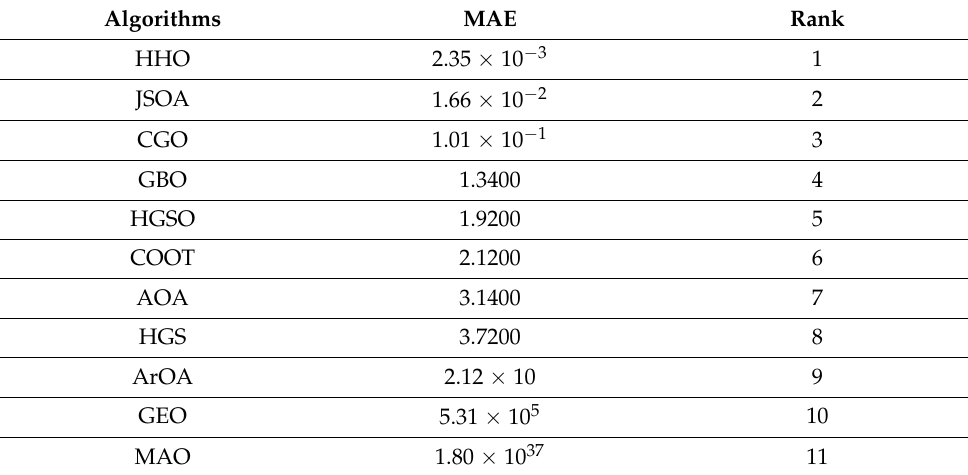
Table 5. Rank of algorithms using